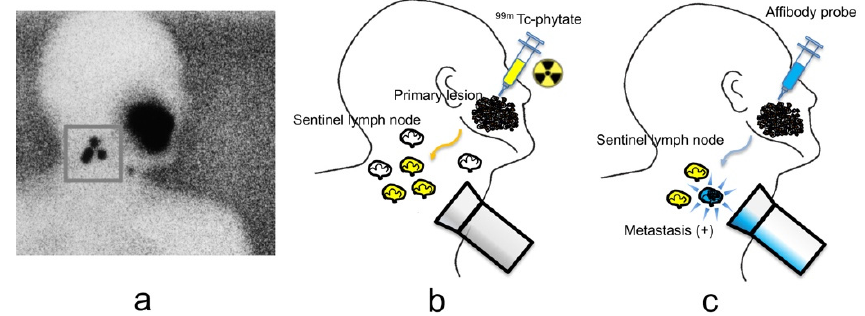
Figure 6. ( a ) Lymphoscintigraphy ( 99m Tc-phytate) in a patient with oral cancer shows increased uptake in sentinel lymph nodes; ( b ) the locations of the sentinel lymph nodes (yellow), even those deeply within the body, could be detected by 99m Tc-phytate injection around primary tumor; ( c ) after identification of the sentinel lymph nodes, metastatic cancer cells (blue) in those lymph nodes could be revealed by NIR fluorescence imaging during the biopsy procedure. Metastatic cancer cells may be eradicated by photoimmunotherapy.